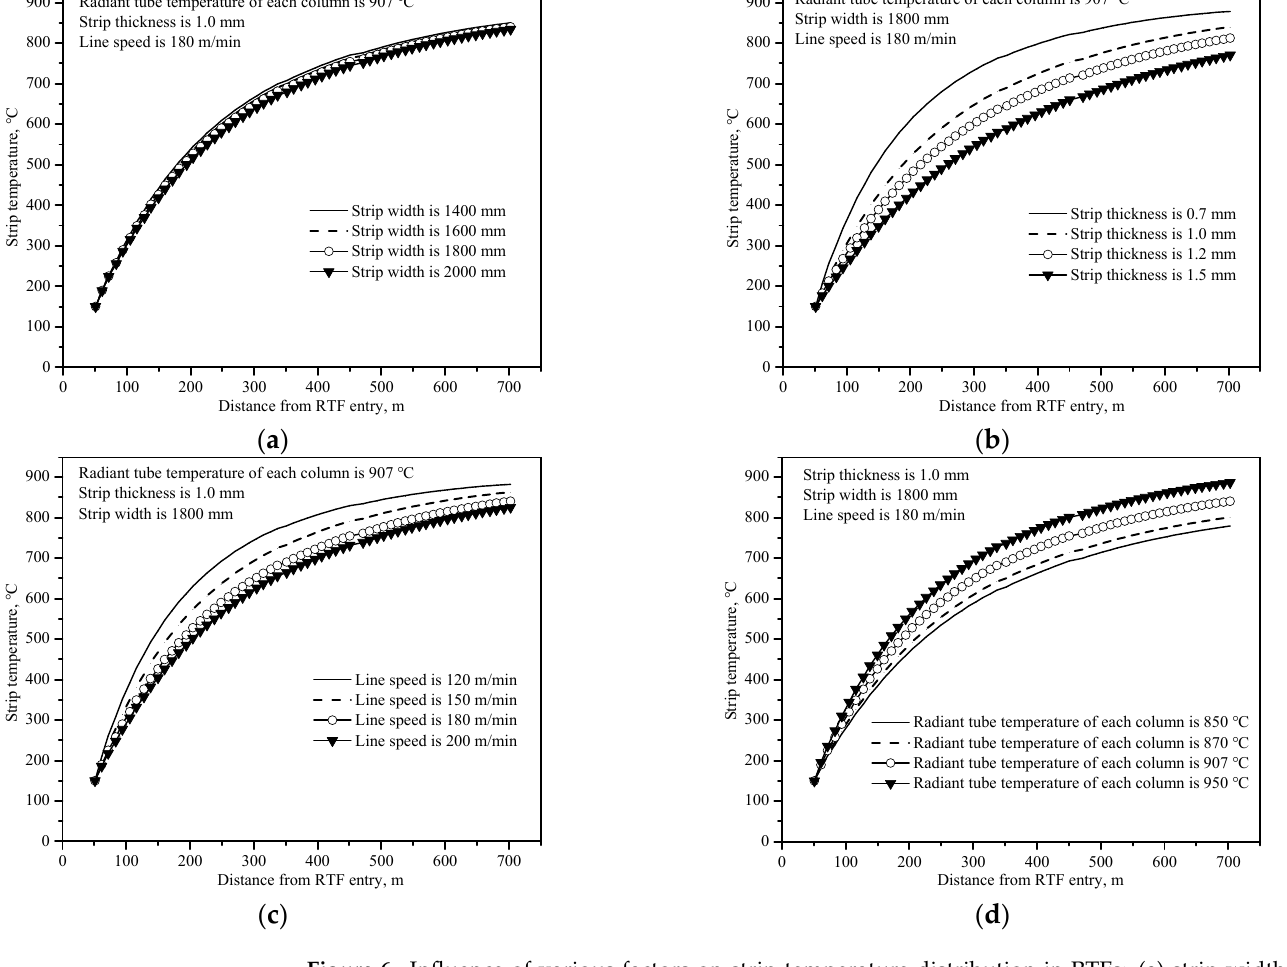
Figure 6. Influence of various factors on strip temperature distribution in RTFs: ( a ) strip width, ( b ) strip thickness, ( c ) line speed, and ( d ) radiant tube temperature of each column.